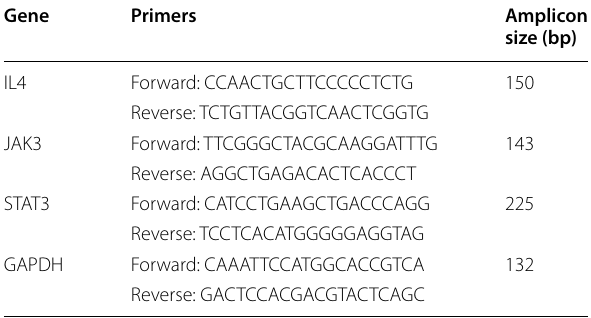
Table 1 Primers used in